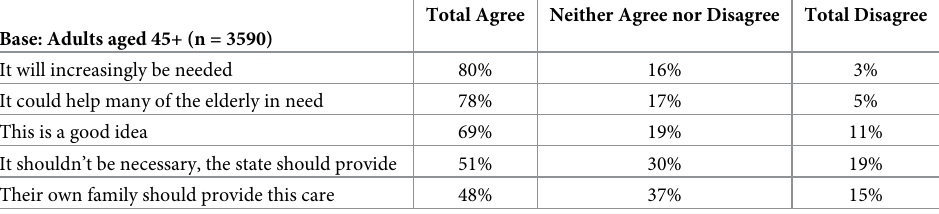
Table 3. Opinions on or related to the community care